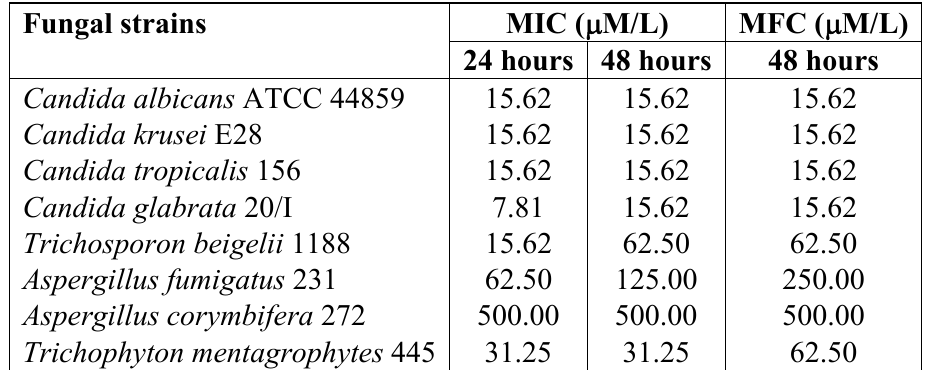
Table 3. In vitro antifungal activity of compound 5